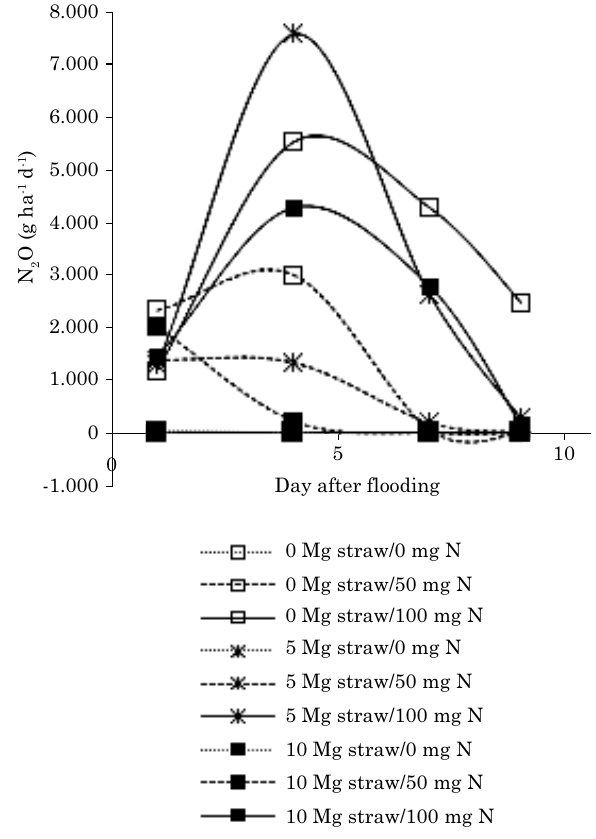
Figure 1. Daily flux rates of N 2 O from flooded soil in pots covered with different quantities of rice straw (0, 5 and 10 Mg ha -1 ) and rates of NO − 3 -N (0, 50 and 100 mg kg -1